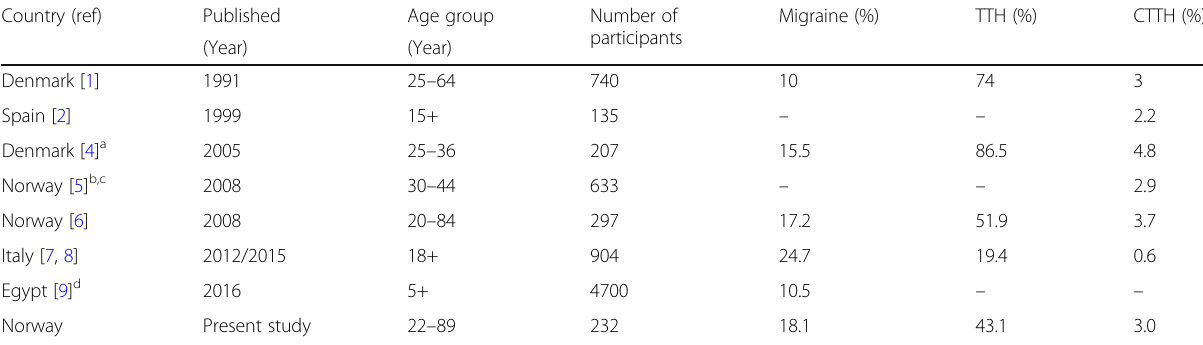
Table 3 Summary of 1-year prevalence of population-based studies which included a face-to-face interview performed by headache experts